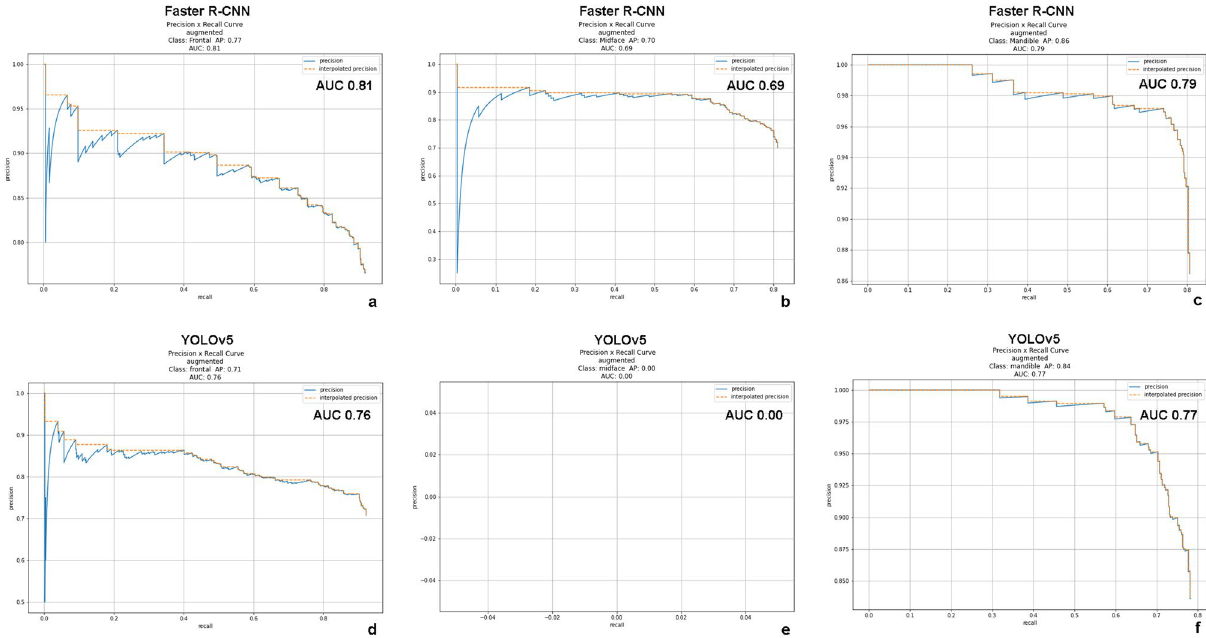
Figure 4. The precision-recall curves for multiclass object detection of faster R-CNN ( a – c ) and YOLOv5 (d-f) for detecting a location of maxillofacial fracture. The AUC of the faster R-CNN and YOLOv5 were 0.81, 0.76, 0.69 and 0.00, 0.79, 0.77 for detection of frontal ( a , d ), midface ( b , e ), and mandibular ( c , f ) fractures, respectively. AUC area under the precision-recall